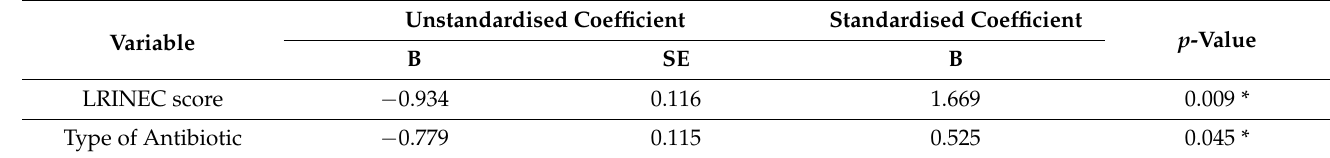
Table 6. Multiple linear regression analysis for the predictors of the amputation